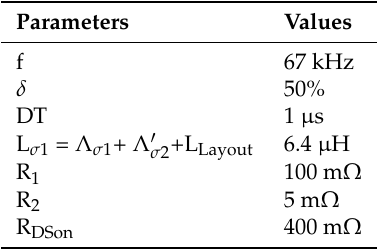
Table 1. Calculation